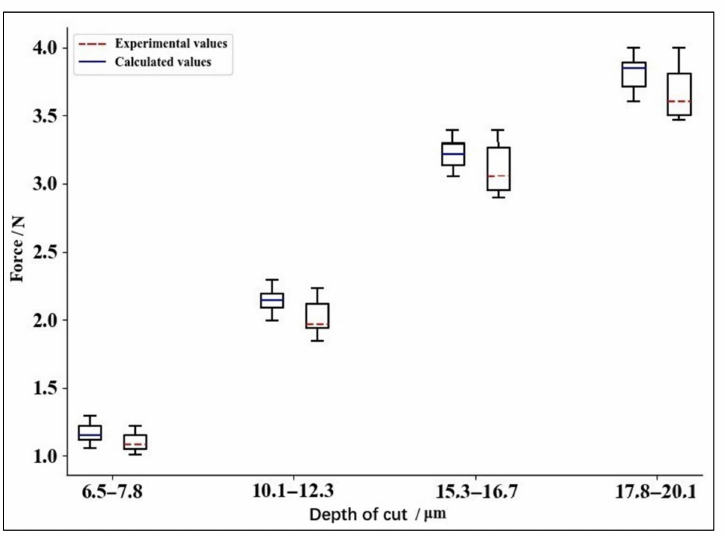
Figure 16. Comparison between FE simulation results and the scratch